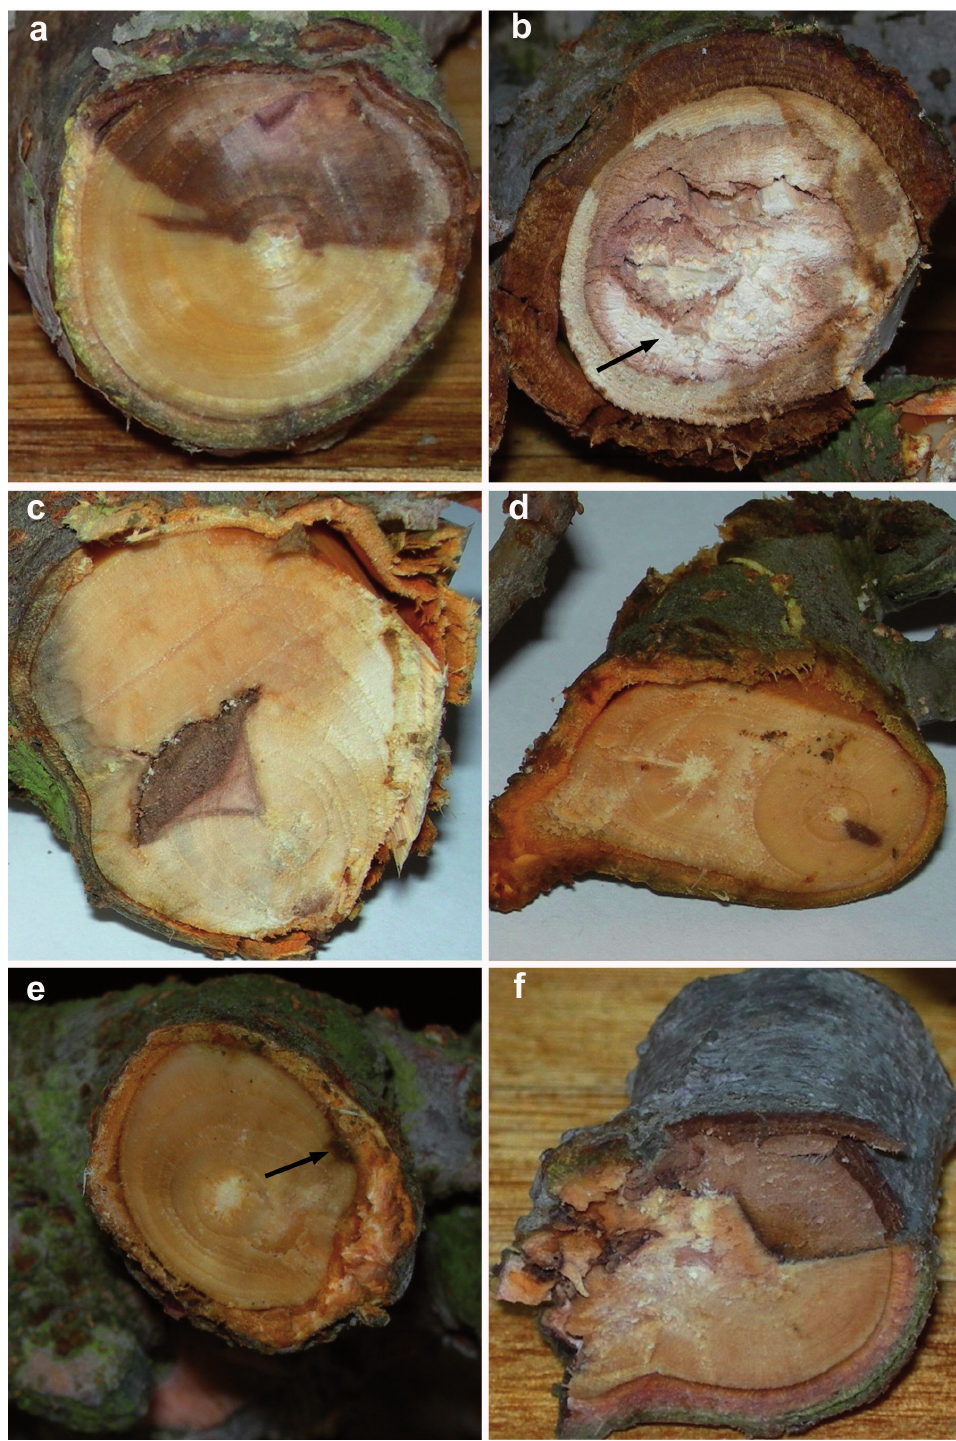
Figure 4. Symptom types associated with trunk disease on pome fruit trees, a) watery necrosis, b) soft rot indicated by arrow, c) brown internal necrosis, d) black/brown streaking, e) brown streaking, f) wedge-shaped